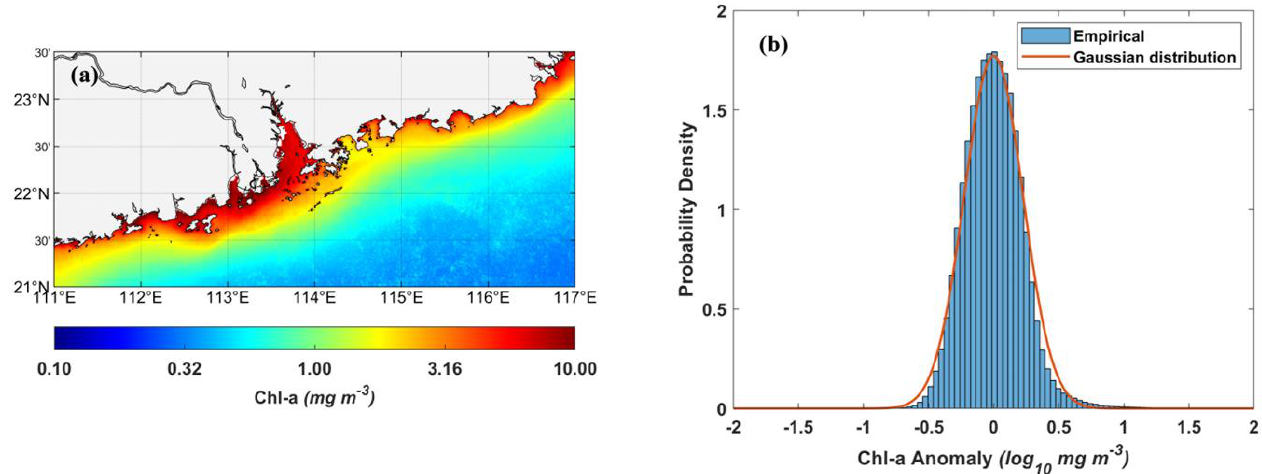
Figure 4. ( a ) Averaged C chla over 2003 to 2020 using valid pixels; ( b ) Estimated probability distribu- tions of the C chla anomalies of the whole dataset (satellite derived, log 10 −transformed).